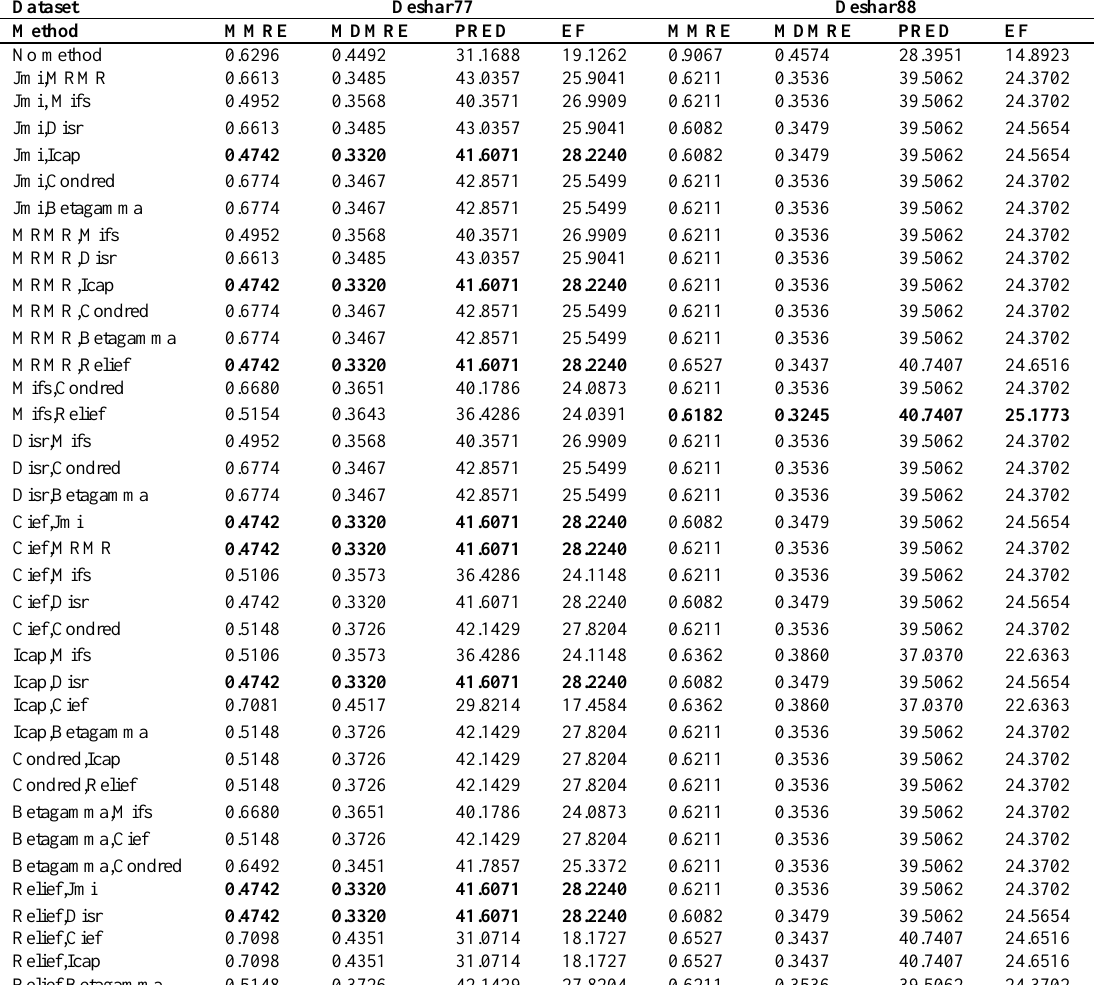
Table 5. Results of implementation on Desharnais dataset. Dataset